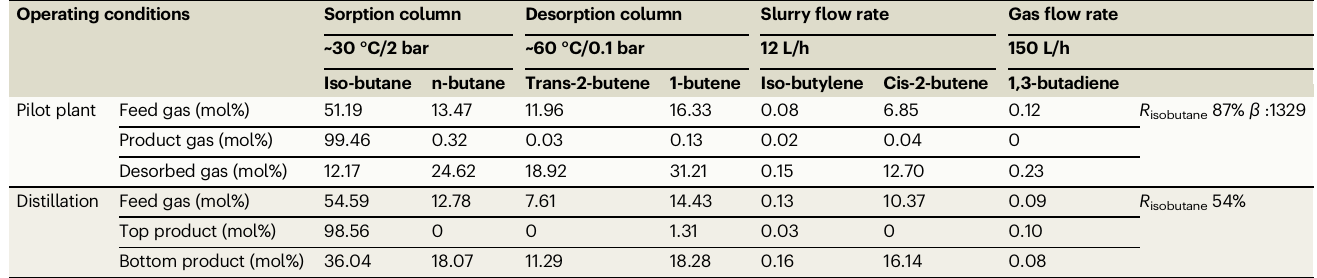
Table 1 | Operating conditions of the pilot plant and a comparison of the separation results between the pilot plant and a Chinese re fi nery using distillation method for the C4 mixtures with similar composition Operating